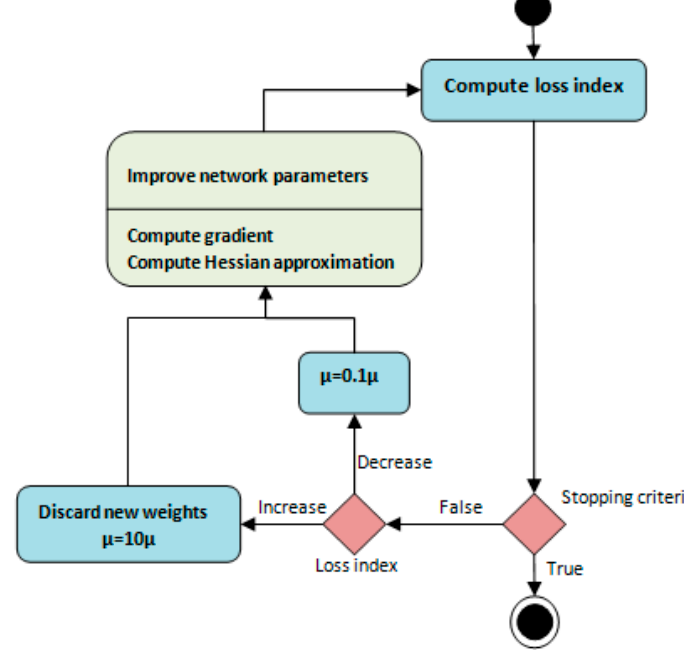
Figure 5. Levenberg-Marquardt (LM) state diagram.